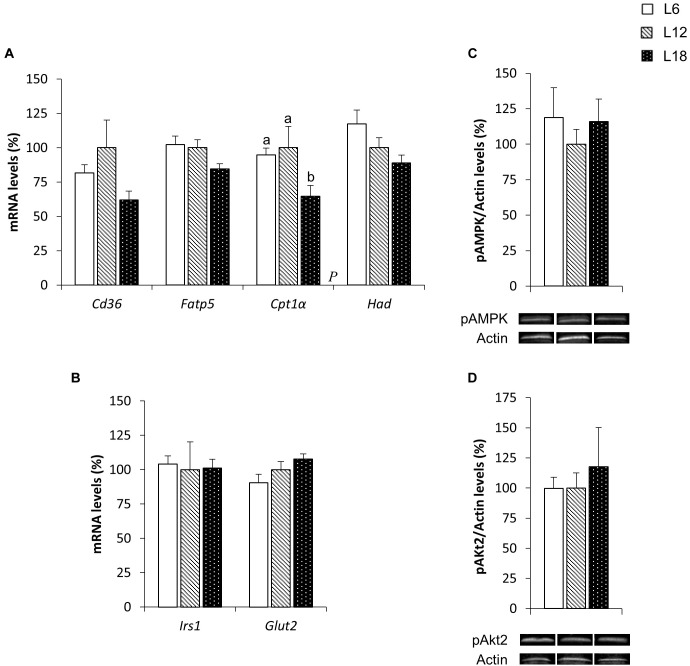
The mRNA expression of genes involved in lipid (A) and glucose (B) metabolism and pAMPK (C) and pAkt2 (D) protein levels in the liver of male F344 rats exposed to three different photoperiods for 11 weeks and fed a cafeteria diet for the last 7 weeks. Data are expressed as the mean ± SEM (n = 8). P, photoperiod effect. abMean values with unlike letters were significantly different among groups (one-way ANOVA and Duncan’s post hoc test). Cpt1α, carnitine palmitoyltransferase 1 alpha; Fatp5, fatty acid transport protein 5; Glut2, glucose transporter 2. The rest of the genes and proteins analyzed have already been described in Figure 3.